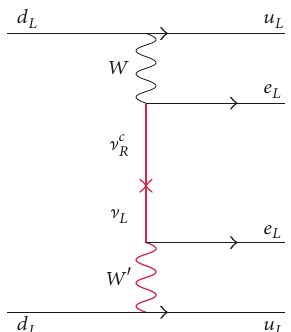
Figure 3: Novel 331 contribution for double beta decay due to light massive neutrinos.